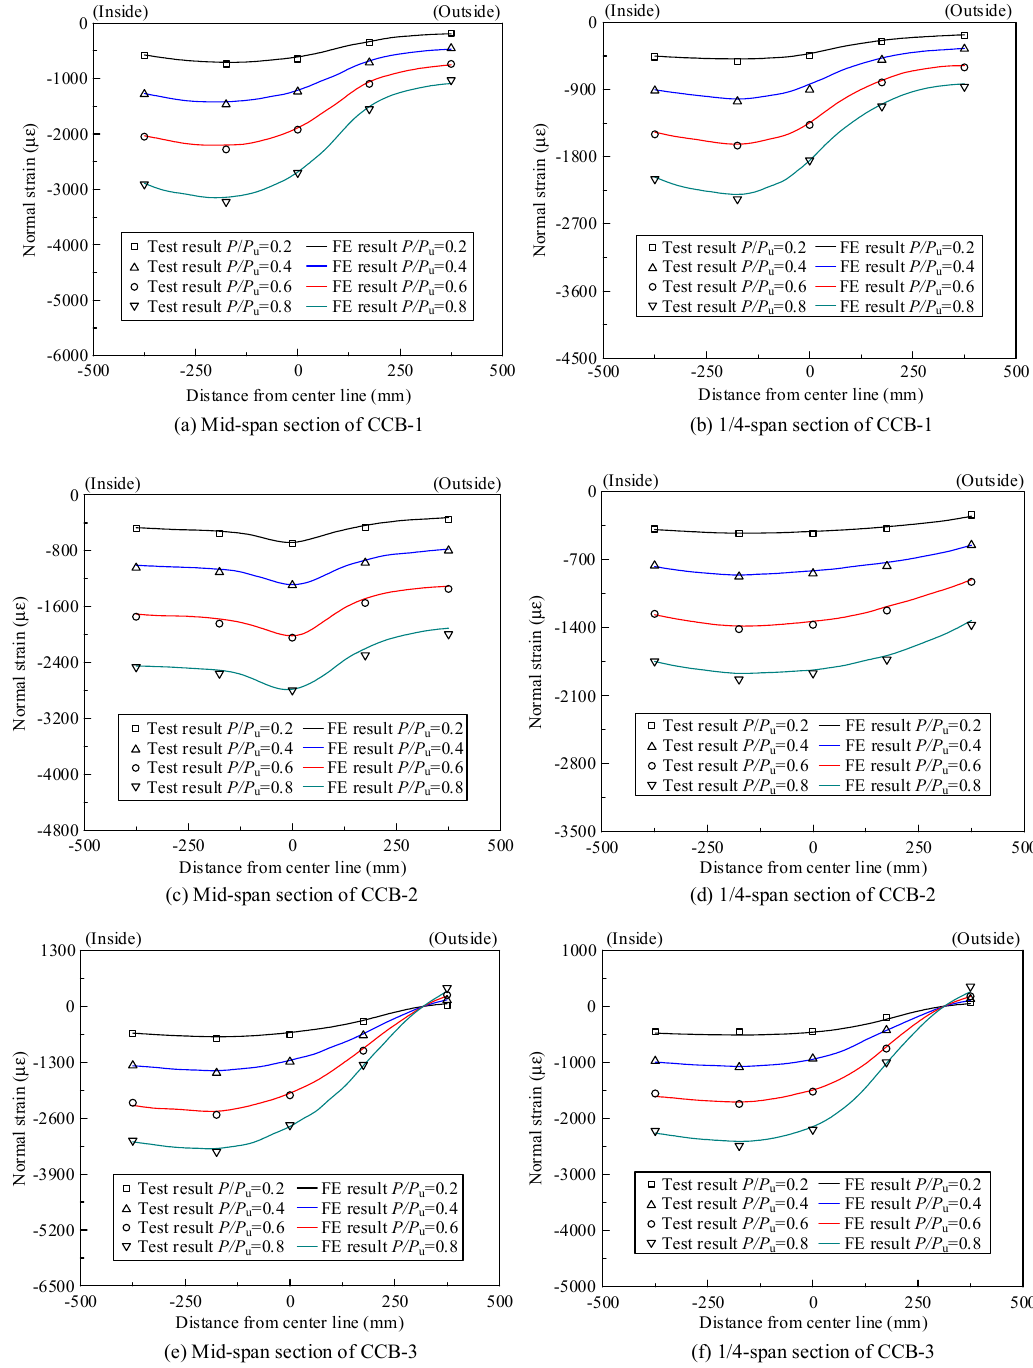
Figure 20. Comparison of the normal strains of the concrete slabs from the test and numerical analyses.